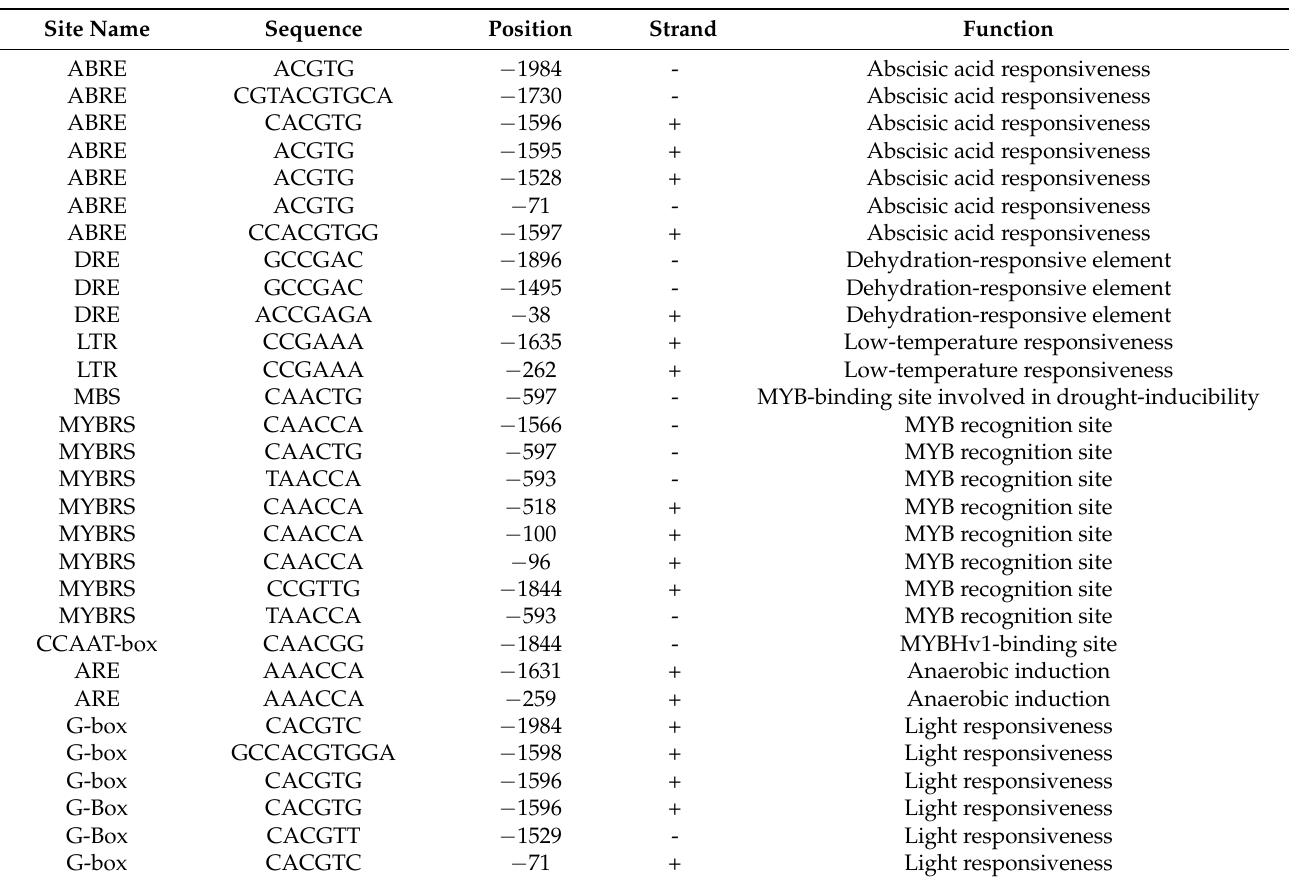
Table 1. Cis-elements in the promoter region (~2 kb) of